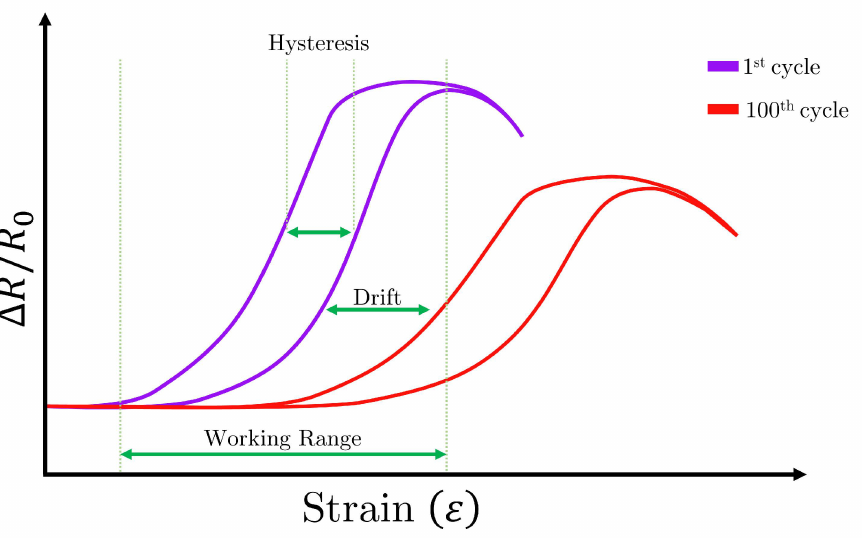
Figure 7. Typical response of a strain sensor when stretched. Here, several properties are shown, including hysteresis, sensor drift, and working range. Note that no scale is provided for the x and y axis, as no real data were used in this